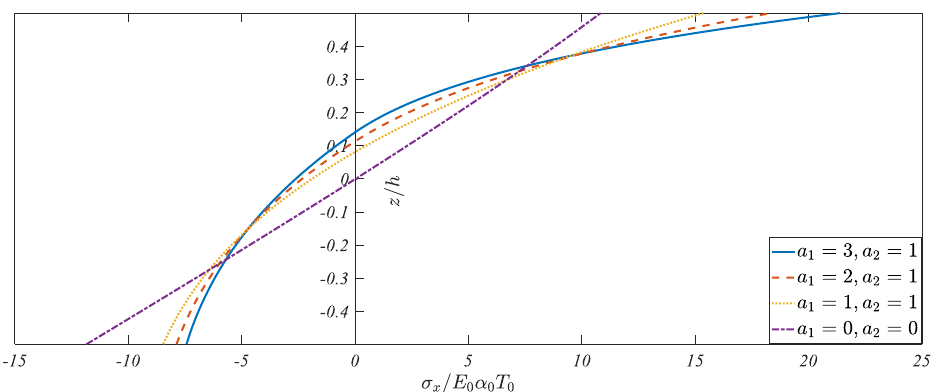
Figure 9. Thermal stresses when E + ( z ) > E − ( z ), in which c = 1, T ( z ) = T 0 e z/h and M/bh 2 = 2 E 0 α 0 T 0 .